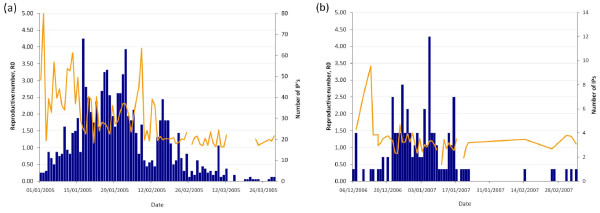
Temporal progression of the newly reported infected premises (IPs) (blue bars) and 3-day moving average of the daily within-flock reproductive number R0 (yellow line), estimated for (a) 924 of IPs from Period I (from 1st January of 2005 to 29th March 2005) and for (b) 106 IPs from Period II (from 6th December 2006 to 7th March 2007) in Vietnam.